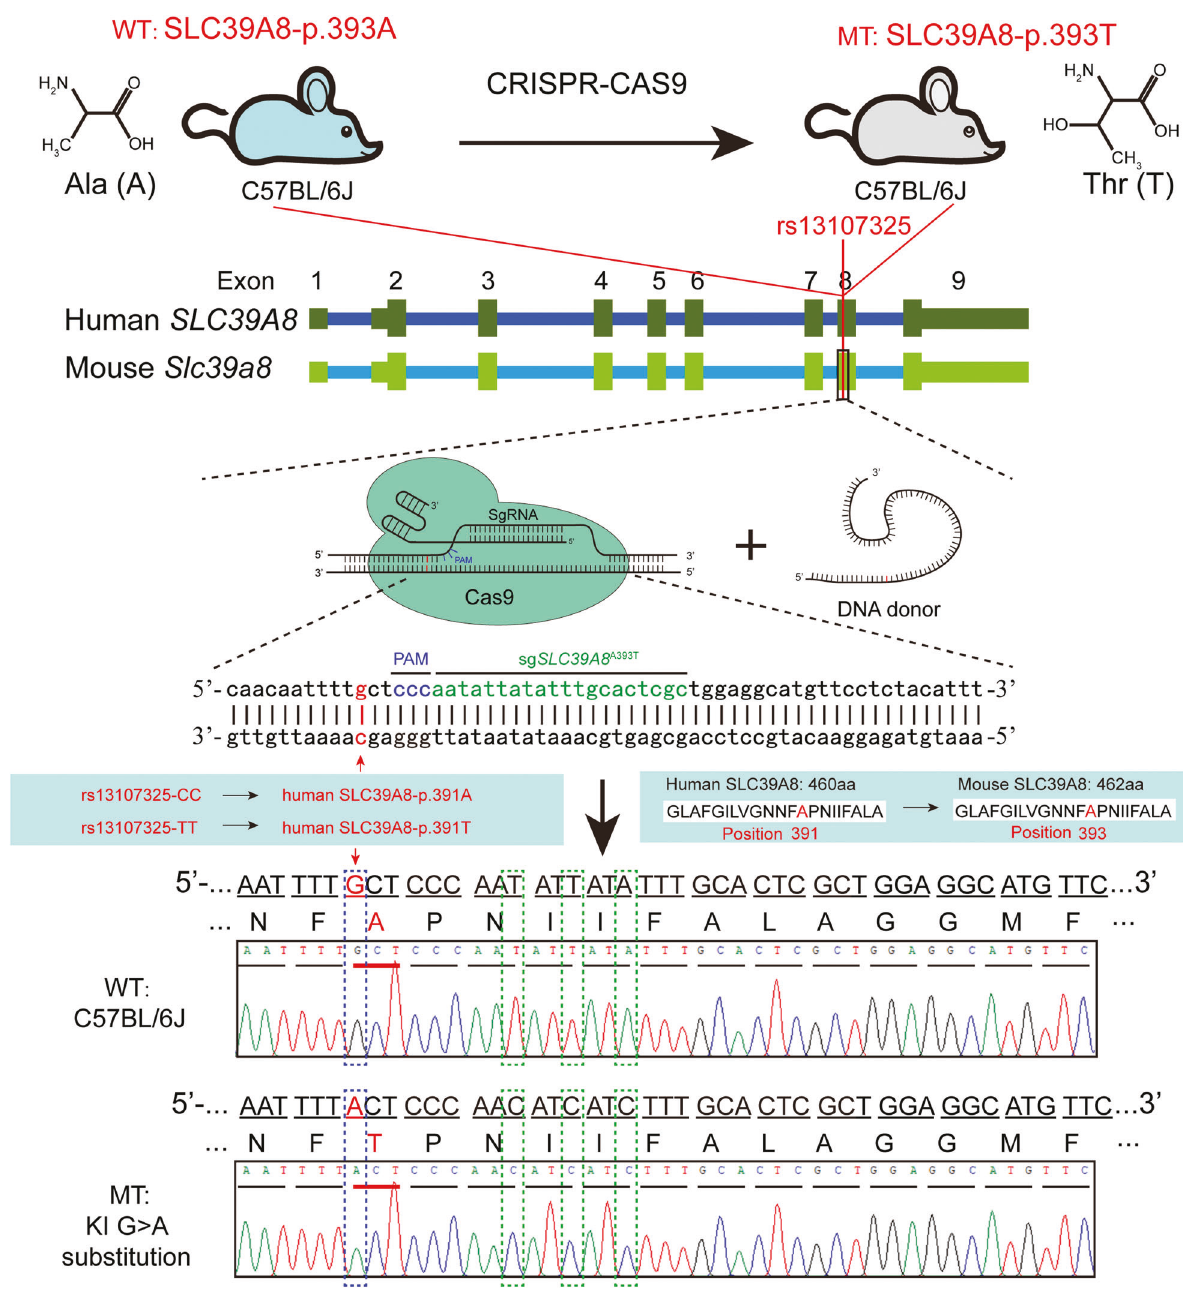
Fig. 1 Generation of the SLC39A8-p.393T knock-in mouse model. CRISPR-Cas9-mediated genome editing was used to construct the SLC39A8-p.393T knock-in mouse model. Human and mouse SLC39A8 gene showed high-degree sequence and structure similarities. The missense SNP rs13107325 is located in the eighth exon of SLC39A8 and encodes p.Ala391T amino acid, which corresponds to mouse SLC39A8- p.393. Sanger sequencing showed that SLC39A8-p.393T knock-in mouse model was successfully generated. The position of SLC39A8-p.393T (corresponds to human rs13107325) was marked by blue dashed box. WT: wild-type mice (SLC39A8-p.393A); MT: knock-in mice (SLC39A8-